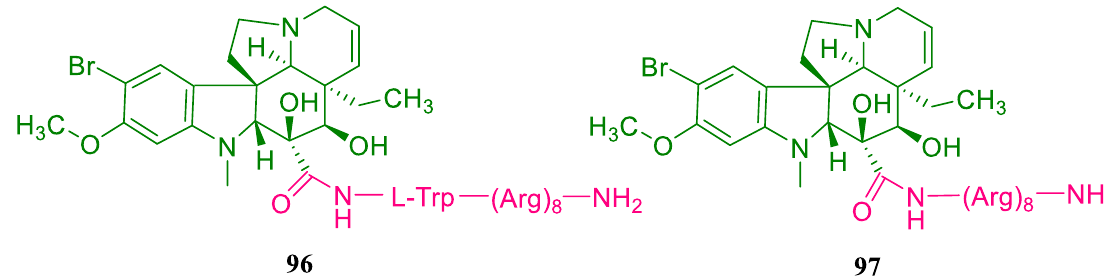
Figure 78. Oligoarginine conjugated to vindoline analogues.